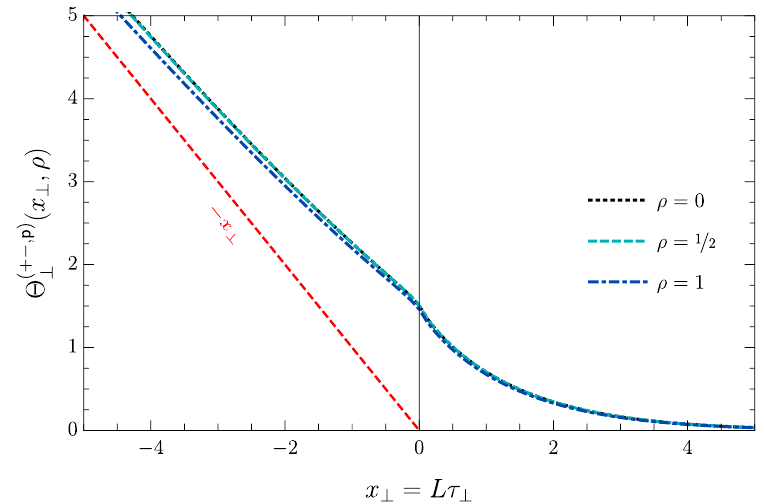
Figure 20: Scaling function Θ ρ ≤ 1. The scaling function converges rather fast towards its limiting case, which is a linear divergence in the ordered phase plus logarithmic